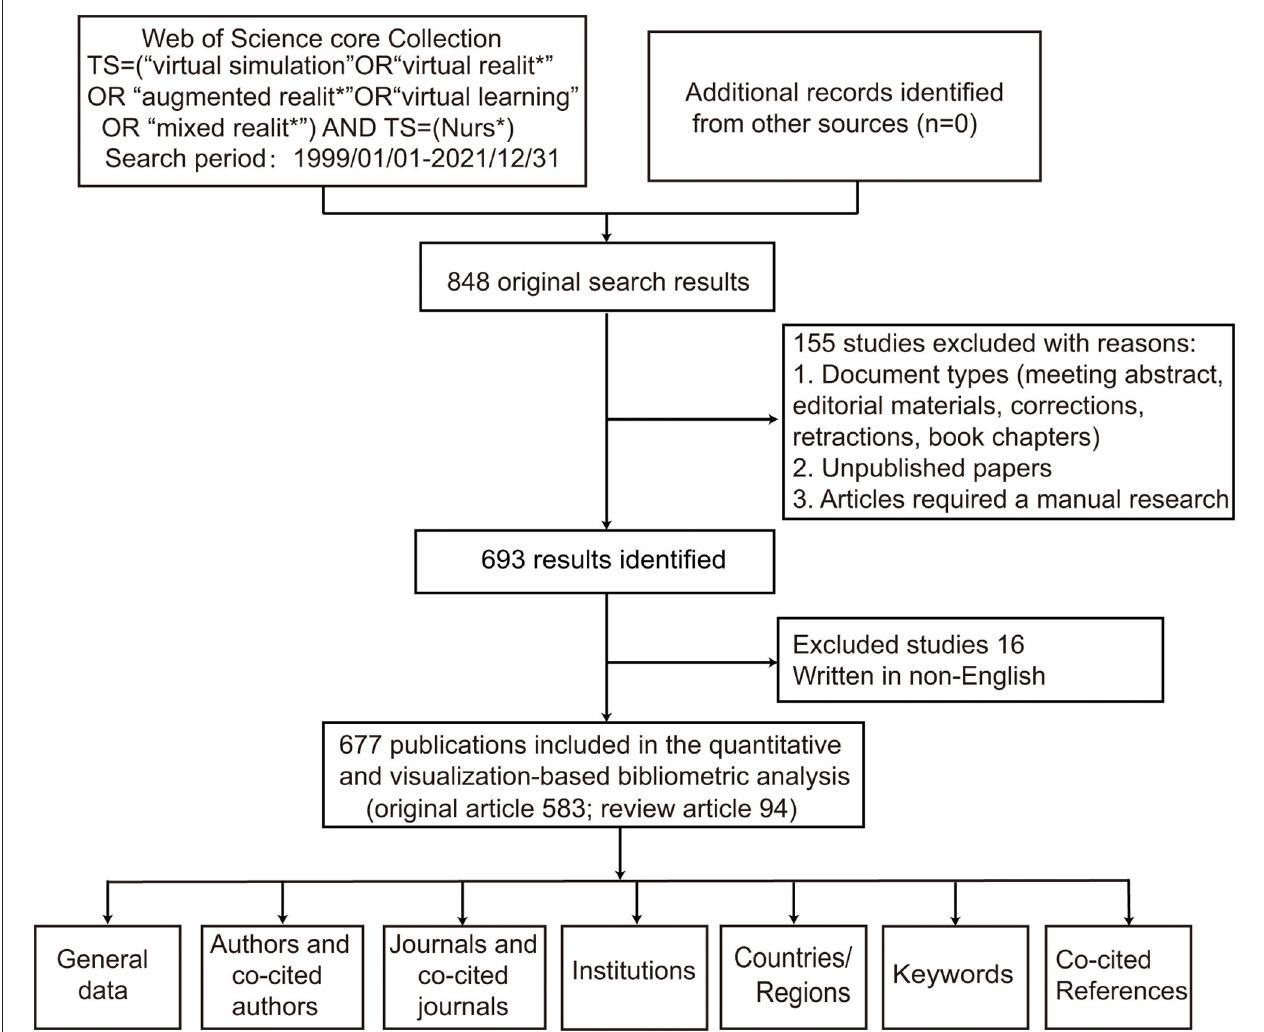
FIGURE 1 | Data screening flow chart. The literature search was performed on WoSCC and language limited to English, and steps of bibliometric analysis.